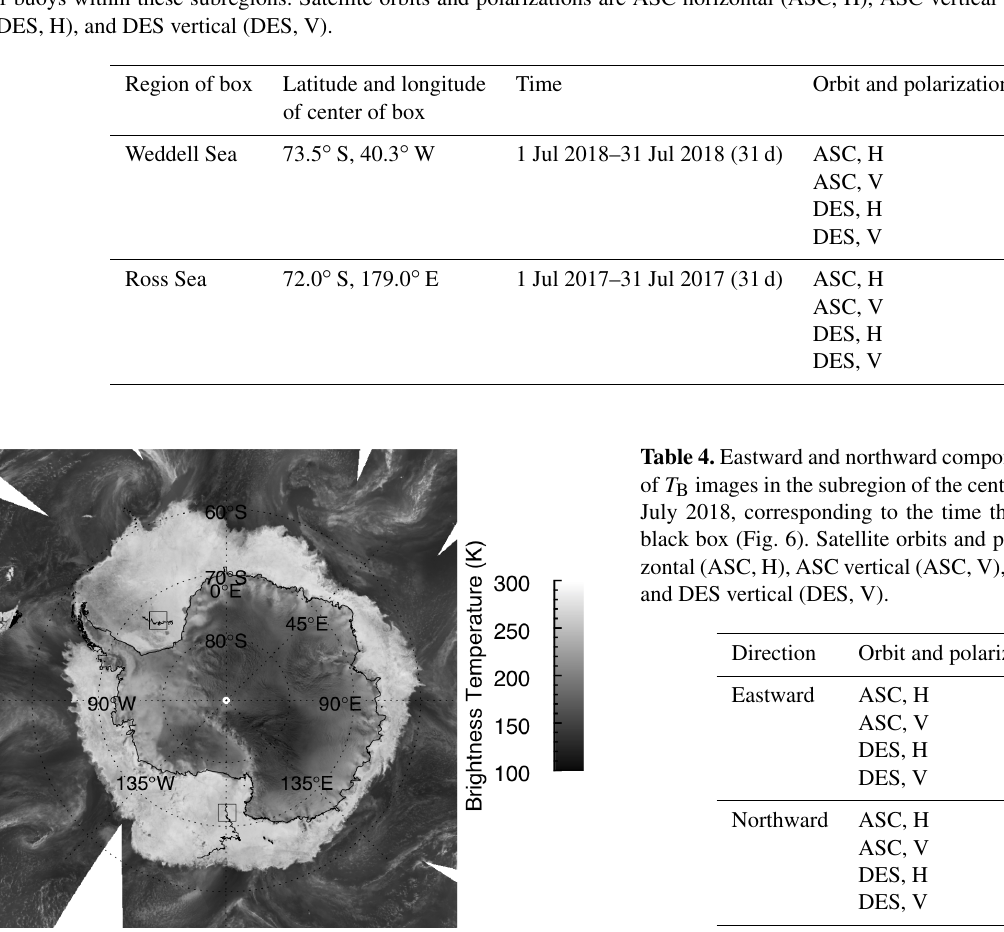
Figure 6. ASC and horizontally polarized daily T B composite ac- quired on 1 July 2018. Buoy trajectories are indicated by black lines in the Weddell and Ross seas. Square black boxes display the loca- tions of subsets centered around the central Weddell Sea and Ross Sea buoys analyzed in Table 3.